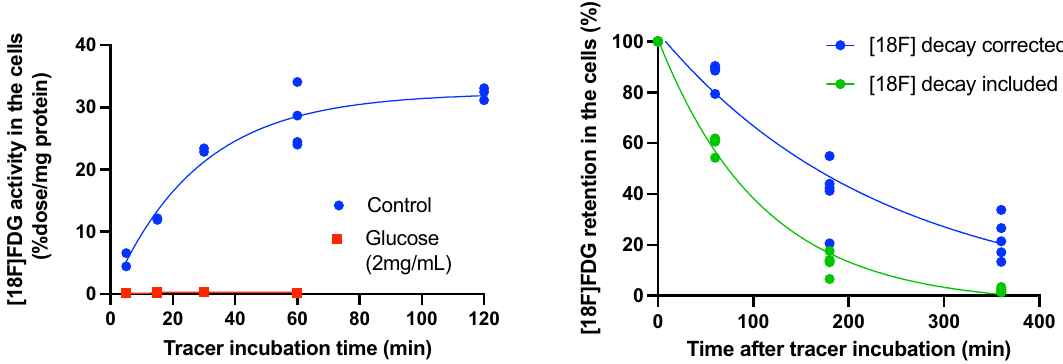
Figure 2. In vitro [18F]FDG uptake kinetics in MSCs (left) and radiotracer washout from the cells (right). Radiotracer activity in the cells was plateaued at 60–120 min incubation (physiological fluorine-18 decay correction). Radiotracer signal remained in the cells at a level of approximately 80–90% after 60 min, while decreased by nearly 50% after 180 min.